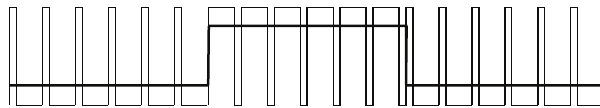
Figure 1: Pulse stream with two complementary duty cycles (25% and 75%) corresponding to logic “0” and logic “1.” The bold line on top is the associated average value with voltage levels corresponding to the logic